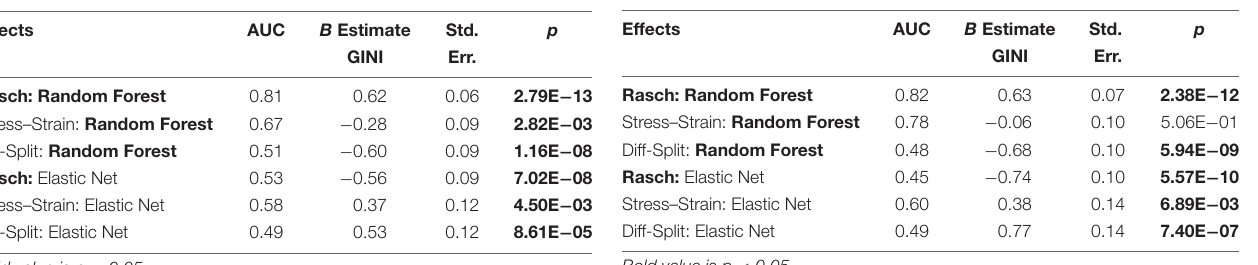
TABLE 2 | ISR hold-out participants.